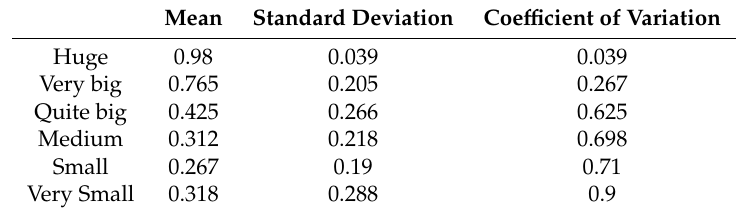
Table 2. Relative e ffi ciency in the pharma and biotechnological European industry by size, 2010–2018. Mean